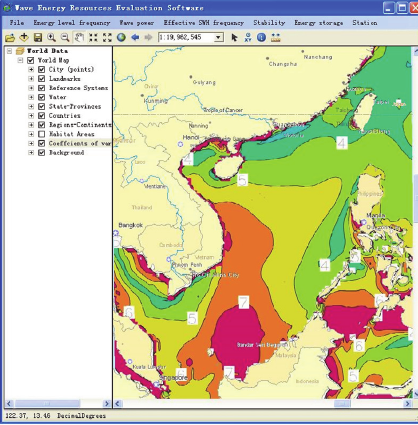
Figure 6: The frequency of wave power densities above 2 kW/m in the South China Sea (percentage